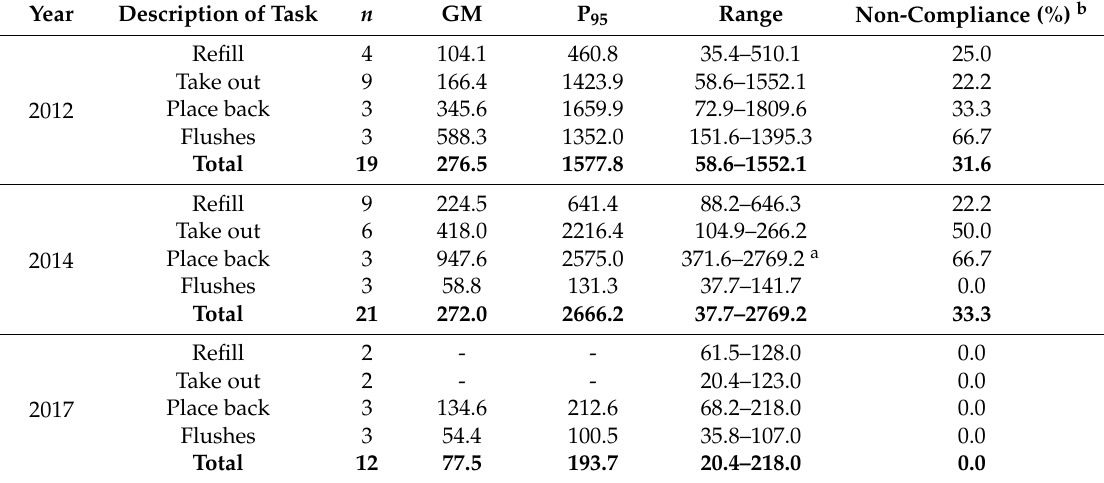
Table 5. Geometric mean concentrations (range) of FA ( µ g/m 3 ) of task-based 15 min measurements in the breathing zone.